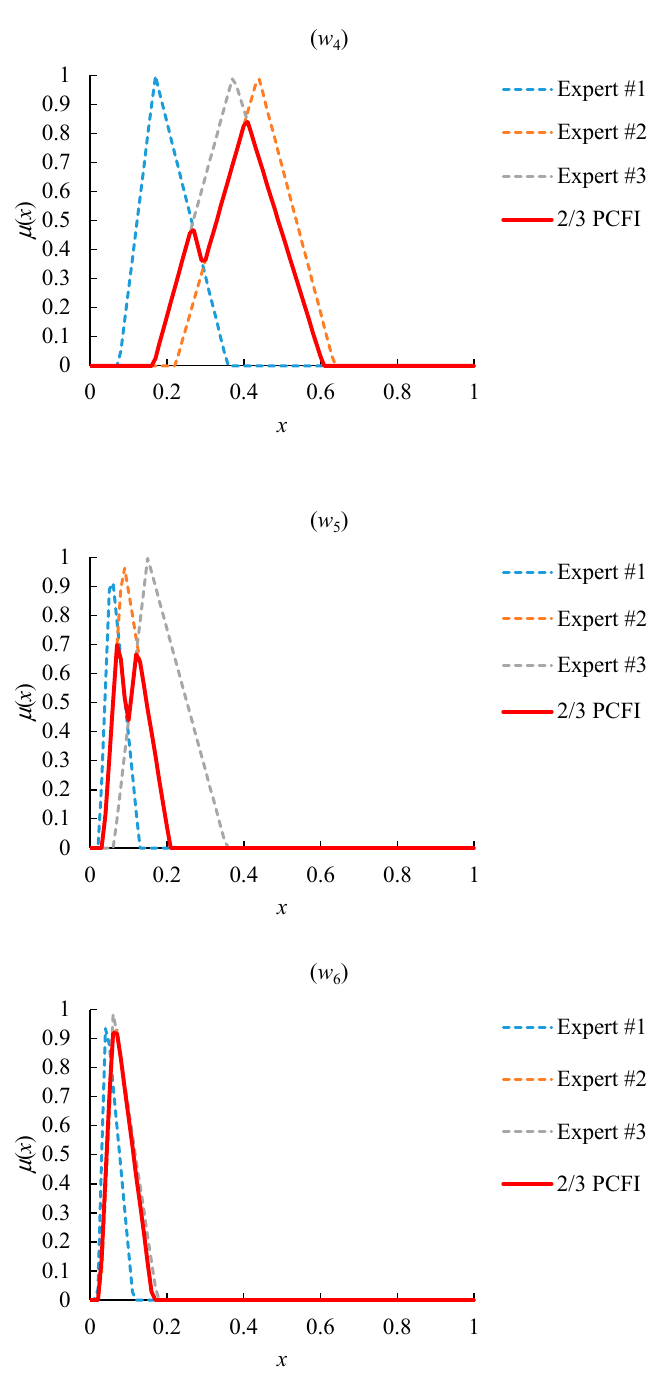
Figure 11. The 2 / 3 PCFI Figure 11. The 2/3 PCFI result.